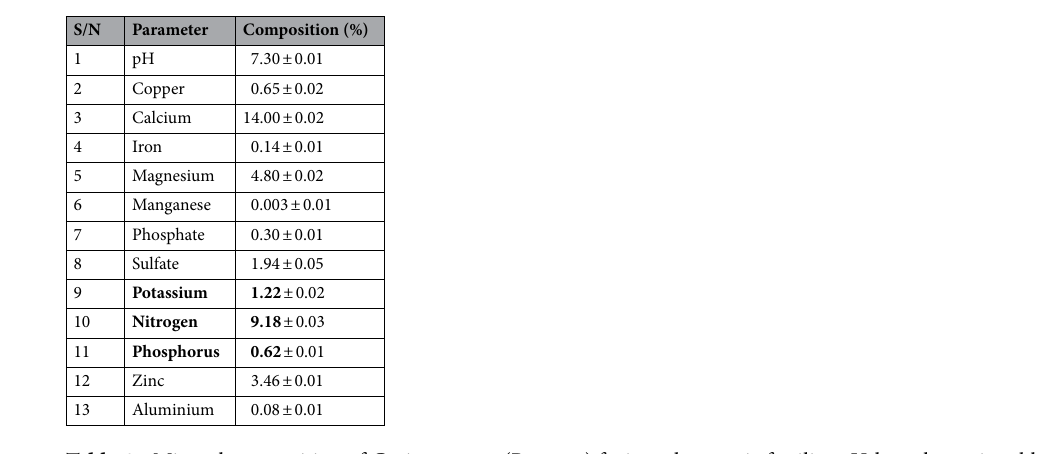
Table 4. Mineral composition of Carica papaya (Pawpaw) fruit peels organic fertilizer. Values shown in table are means of triplicate analyses.